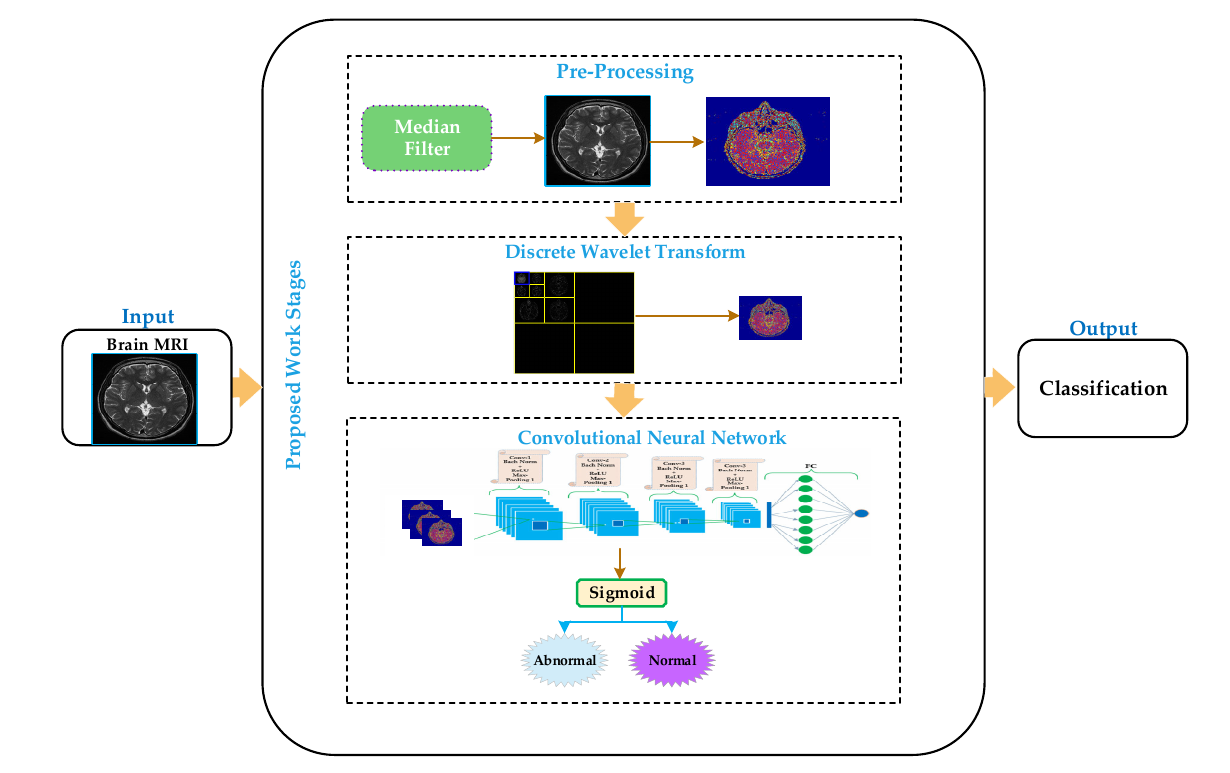
Figure 1. Processing diagram of the proposed model for brain MRI classification.